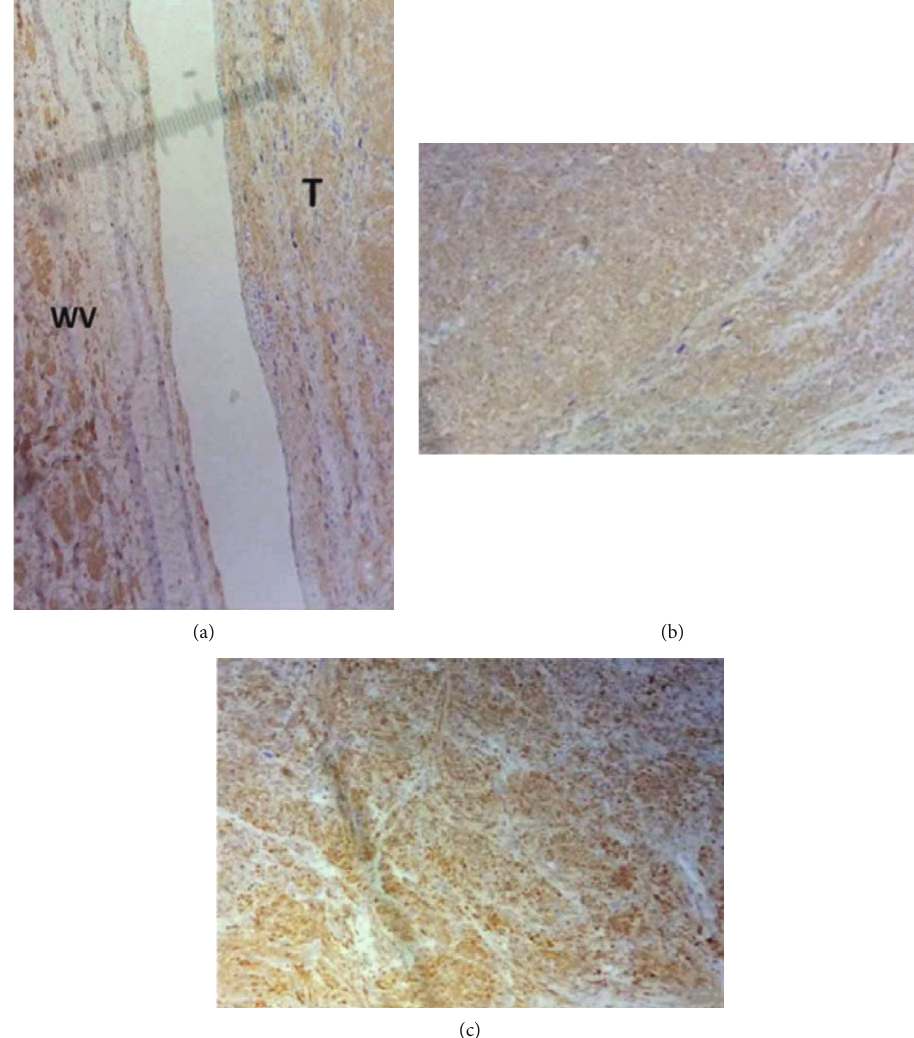
Figure 4: Immunohistochemical study showing di ff use positivity for smooth muscle actin (a), H-caldesmon (b), and desmin